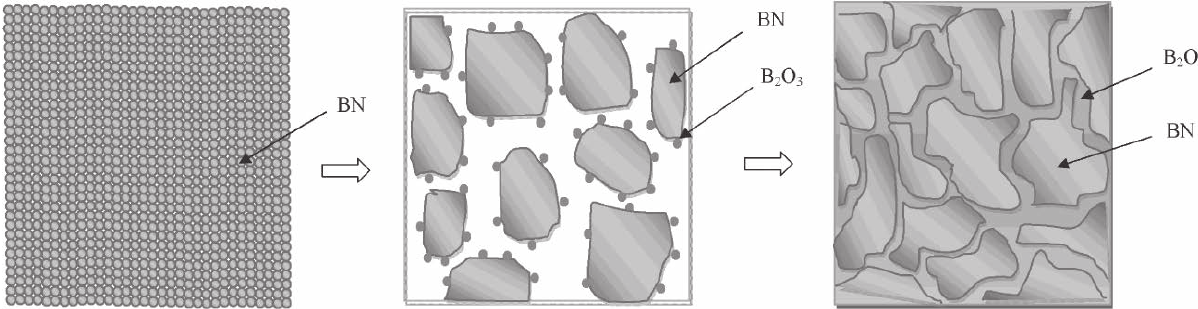
Fig. 7: Schematic diagram of the reaction process of h -BN powder with